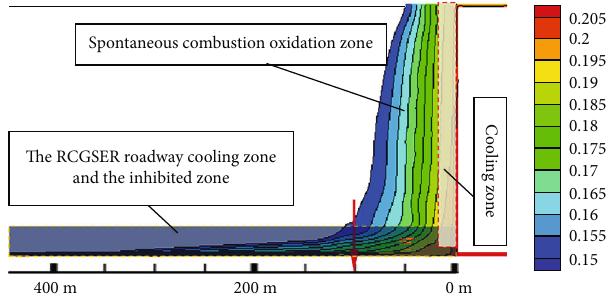
Figure 14: Determination of the spontaneous combustion oxidation zone and scale behind the working